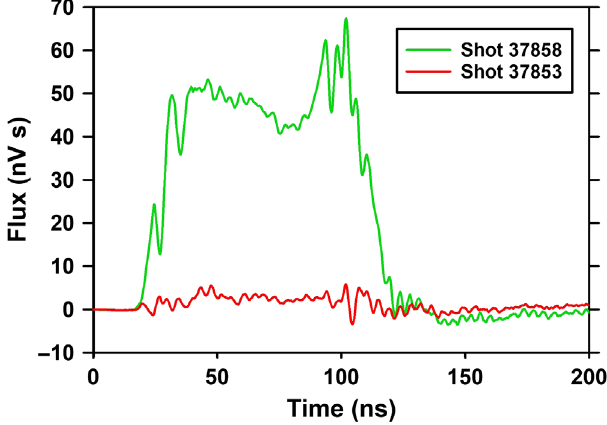
FIG. 6. Integrated loop-flux signal from a shot with 200-G bias field (green curve) compared with the integrated loop-flux signal from a background shot with zero bias field (red curve). (The baseline errors long after the pulse are due to the first-order approximation to correction for cable distortion).